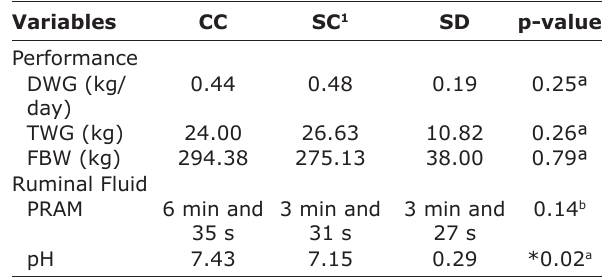
Table-2: Means and standard deviations (SD) of daily weight gain (DWG), total weight gain (TWG), final body weight (FBW), reduction in methylene blue (PRAM), and hydrogen potential (pH) of Nellore calves supplemented (SC) or not supplemented (CC) with ruminal fungi.